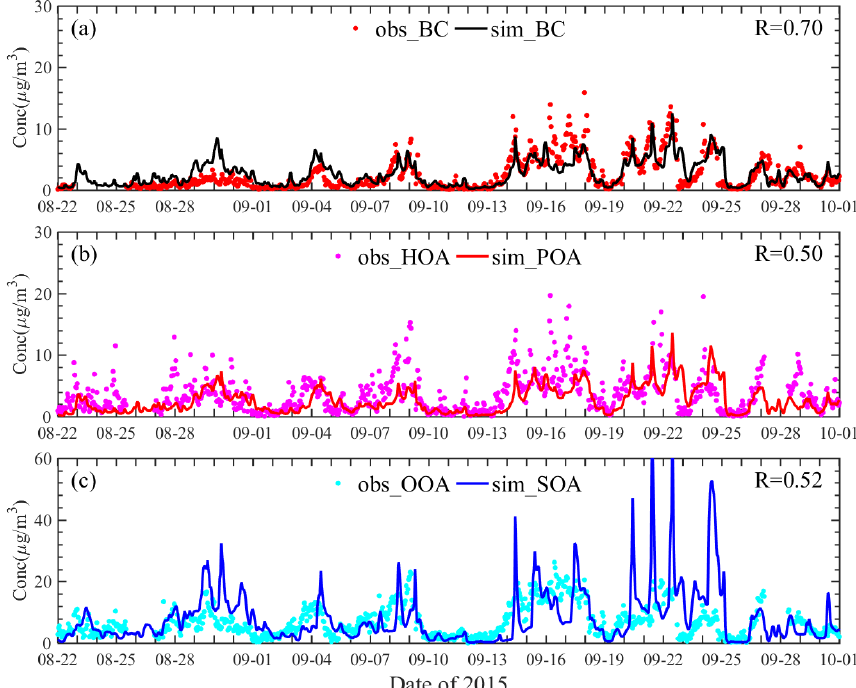
Figure 1. Comparison of the simulated and the observed (a) black carbon, (b) primary organic aerosol, and (c) secondary organic aerosol concentrations at 260m height in Beijing from 22 August to 30 September 2015. All the observations are shown with dot points and the simulations with lines.